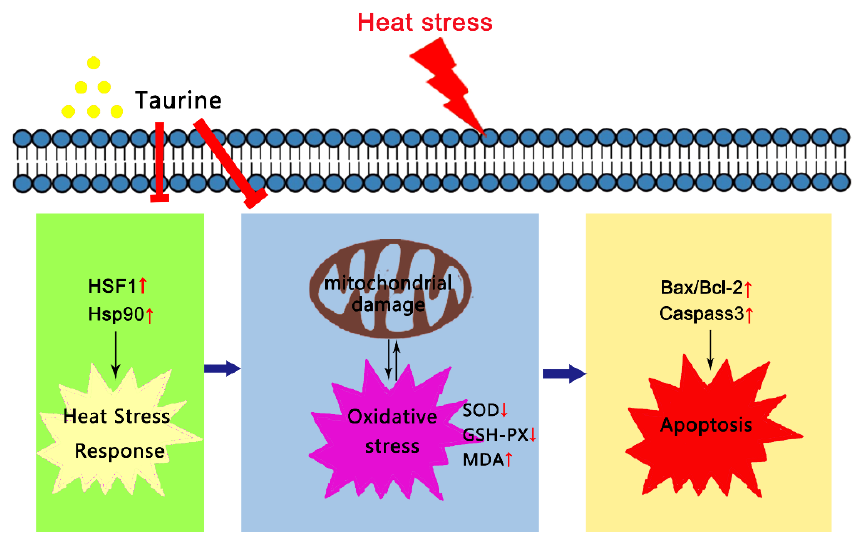
Figure 6. Taurine protected heat-induced MAC-T cells effectively by improving the thermotolerance of cells and reducing the levels of oxidative stress and cell apoptosis.